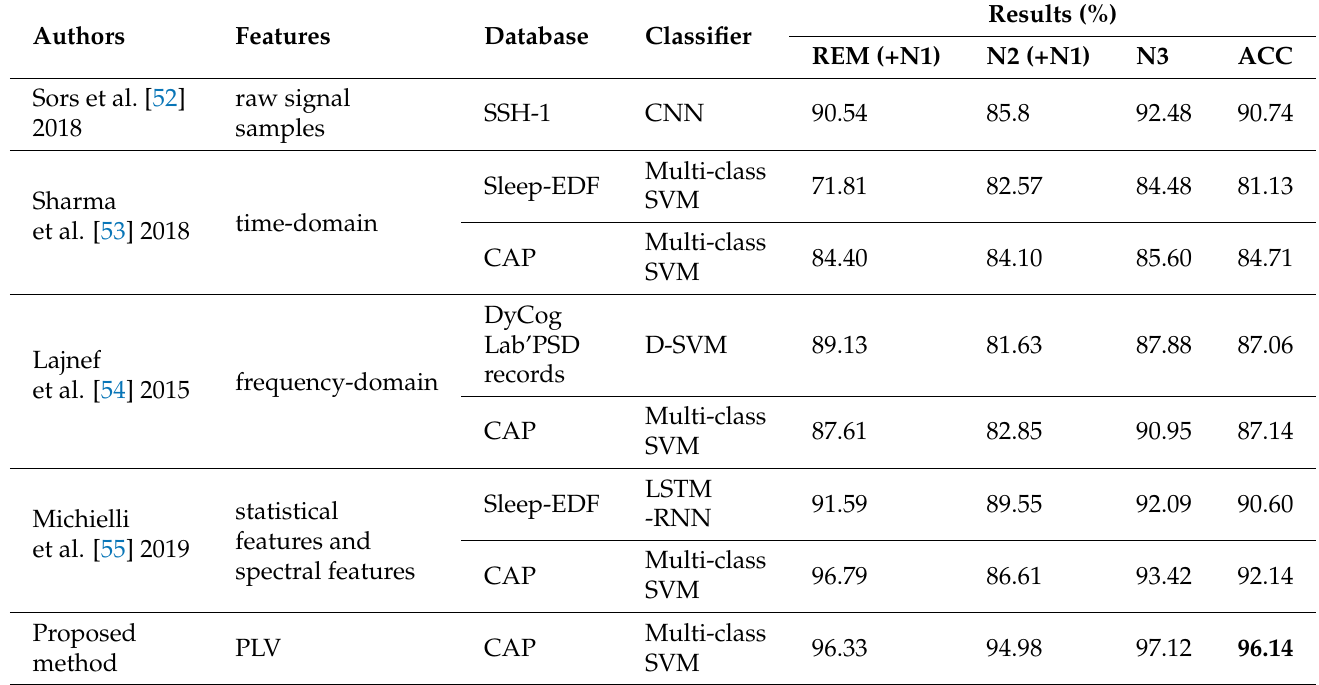
Table 4. Comparison of state-of-the-art